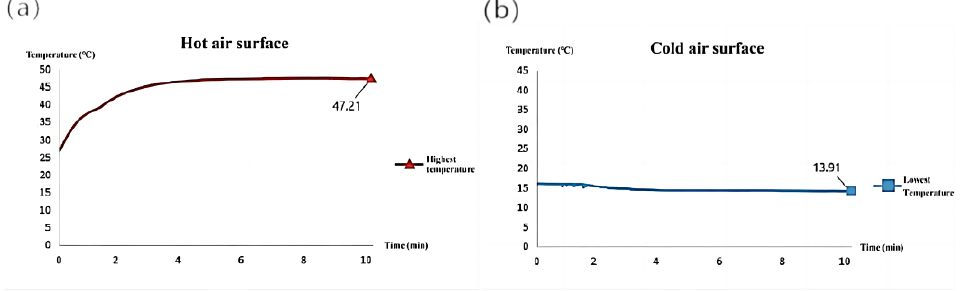
Figure 15. Average temperature and time curve of three measurements. ( a ) Temperature variation curve of hot air surface with time. ( b ) Temperature variation curve of cold air surface with time.